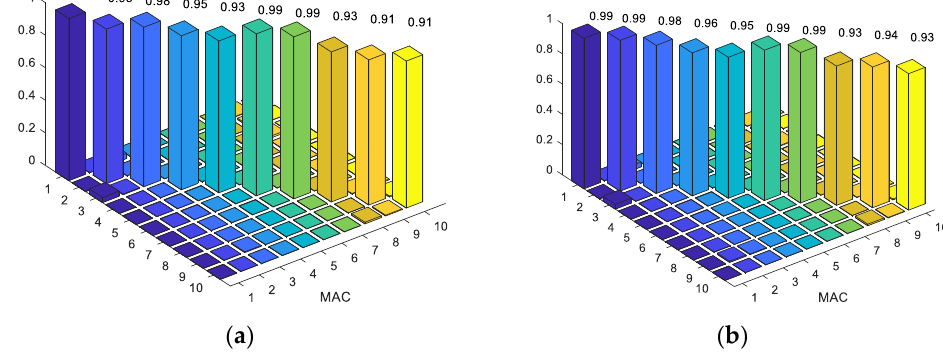
Figure 18. MAC values of mode shapes after model updating: ( a ) GA; ( b ) PSO.